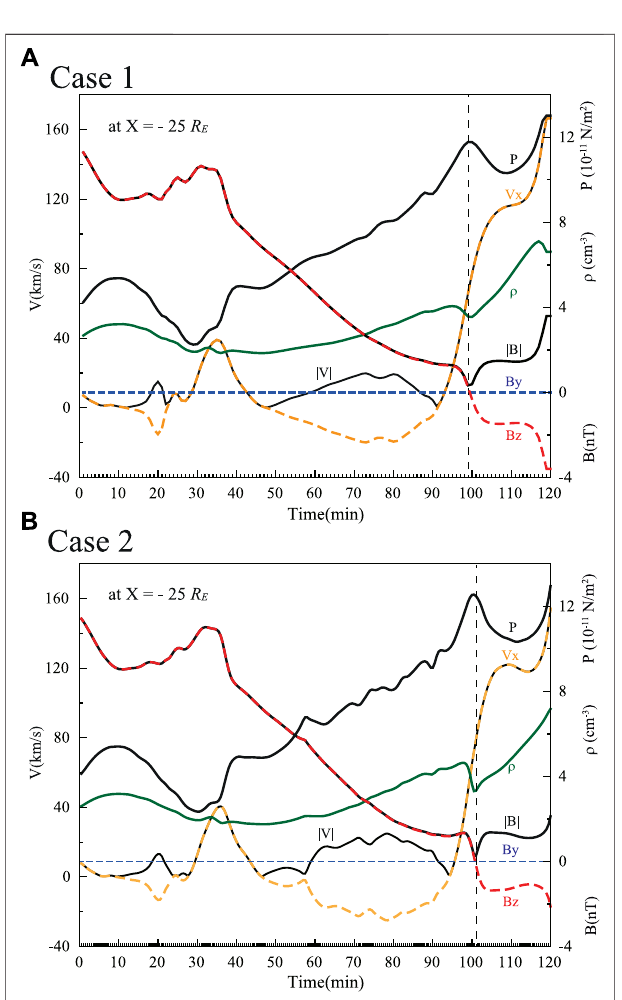
FIGURE 2 | The time evolutions of the strength of magnetic fi eld, |B| , z-component of magnetic fi eld, Bz, and the total velocity |V| , x-component of velocity, V x , the density ( ρ ) and the plasma ( P ) for two